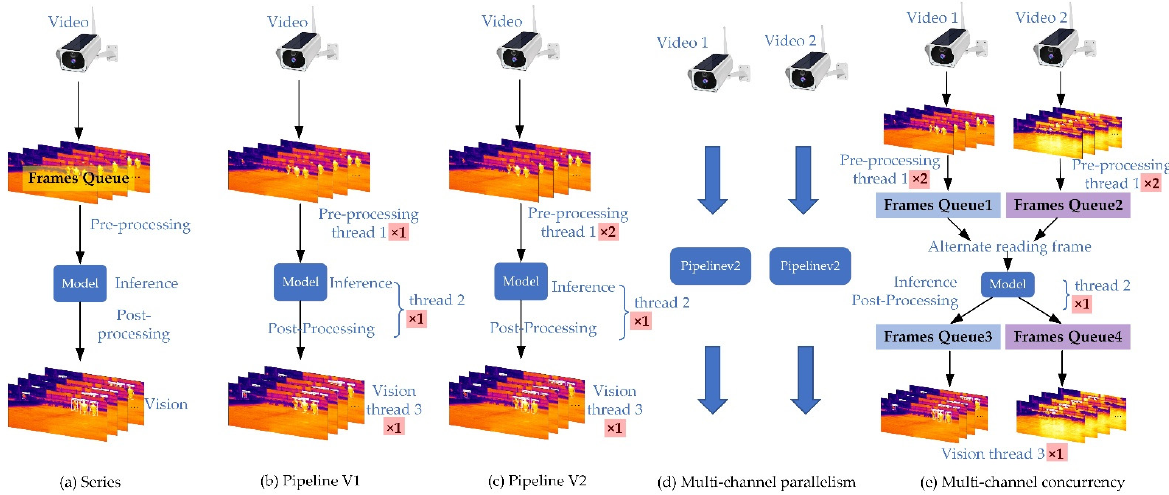
Figure 5. Single-channel and multi-channel video computing acceleration with multi-threading. ( a ) A single thread completes pre-processing, inference, and post-processing; (b) pre-processing, inference, and post-processing are completed by a single thread, respectively; ( c ) differs from ( b ) by adding two threads to the pre-processing; ( d ) video parallelism processing using pipelineV2; ( e ) video concurrency processing using the improved pipelineV2.